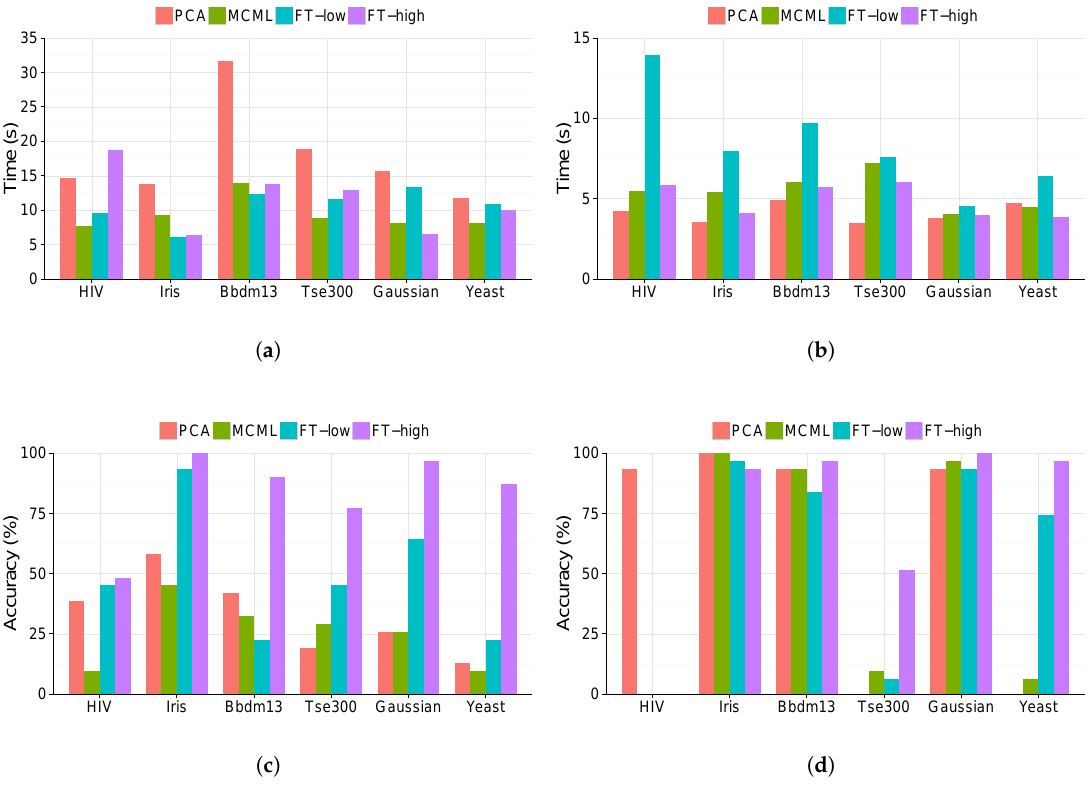
Figure 7. The results of the clustering and outlier task, ordered by data size. ( a ) Completion time of the clustering task; ( b ) Completion time of the outlier task; ( c ) Accuracy of the clustering task; ( d ) Accuracy of the outlier